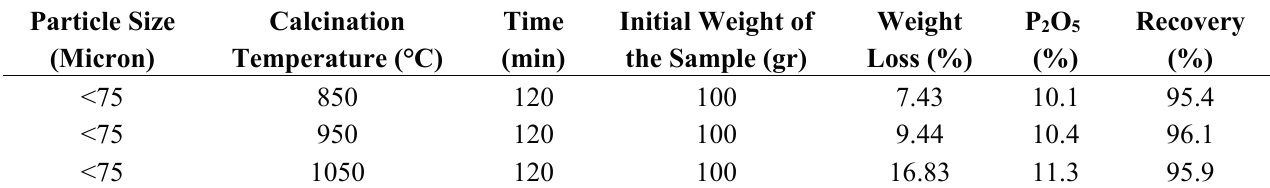
Table 3. Results of calcination of phosphate ore <75 μ m in size.